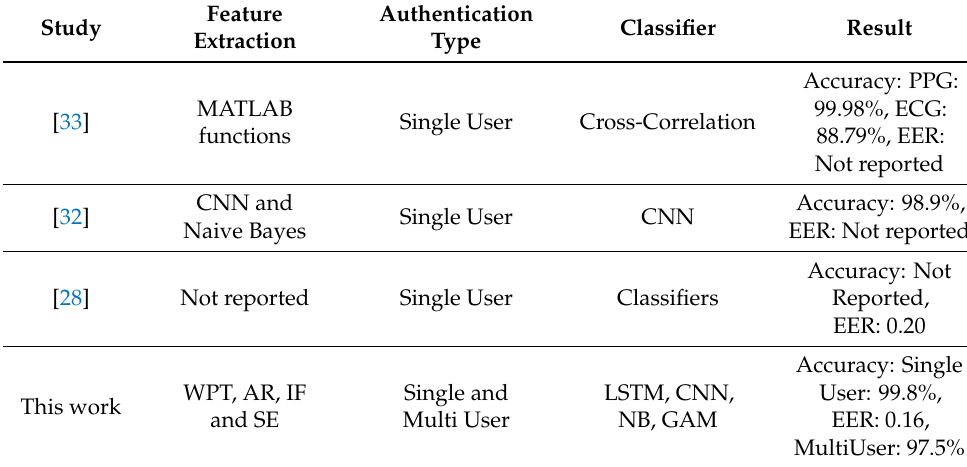
Table 11. Comparison with Multimodal ECG and PPG